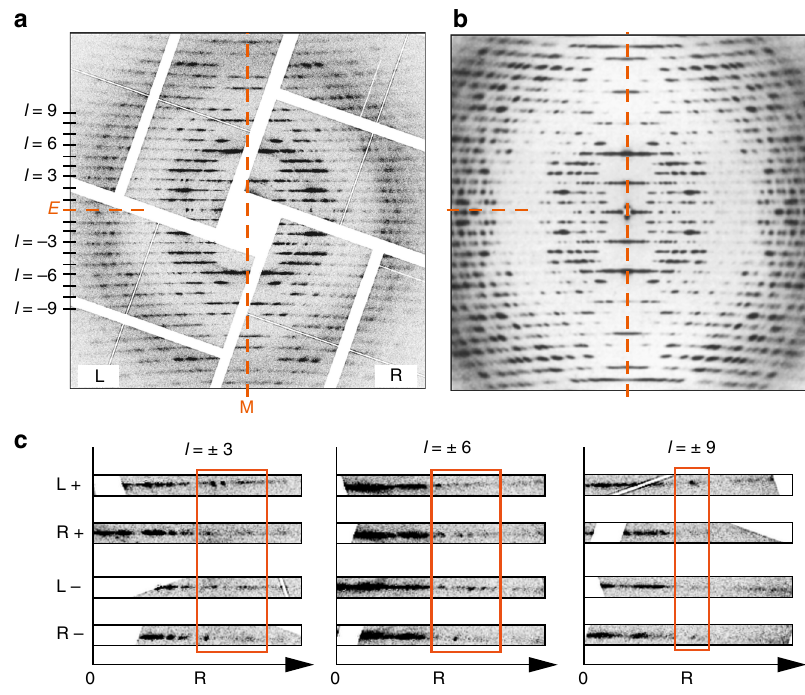
Fig. 4 Comparison of XFEL and conventional X-ray fi ber TMV diffraction patterns. a A single XFEL snapshot of TMV proto fi brils on graphene is shown. The resolution at the center-edge is 3.86 Å. Left and Right layer lines, equatorial and meridional axes are labeled L, R, E, and M, respectively. b A classical X-ray fi ber diffraction pattern from millions of mutually aligned TMV fi brils. Reprinted from publication 6 , Copyright (1989), with permission from Elsevier. c Magni fi cations of three symmetry related layer lines ( l = ± 3, l = ± 6, l = ± 9) are shown as a function of resolution R. The left and right sides of the layer lines are indicated with L and R, and positive and negative layer lines with + and − , respectively. The left layer lines are fl ipped along the vertical axis to match the pro fi le of the right layer